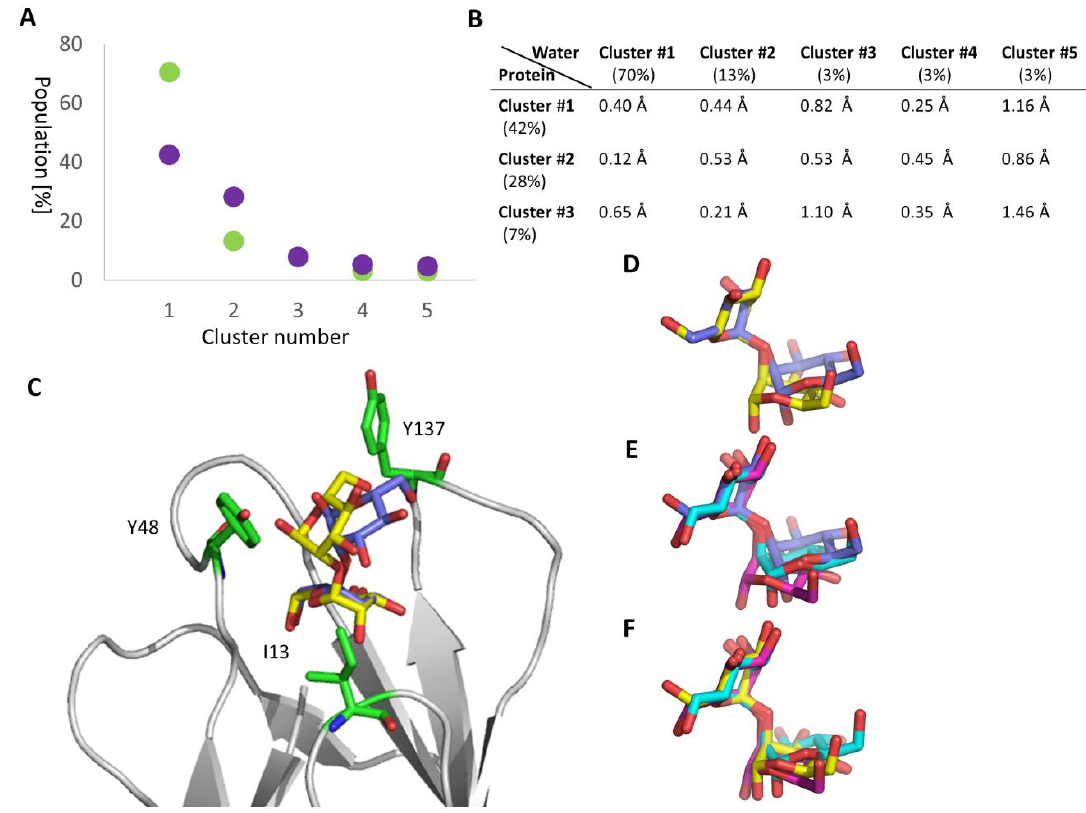
Figure 5. Molecular details of Man α 1,2Man binding to FimH. ( A ) Clusters featuring similar structures were extracted from the MD simulations of Man α 1,2Man in the FimH binding site (lilac) and in water (green) and plotted against their population occurrence (in %). Only the five highest ranking clusters are depicted, which account to 95% and 89% of the conformations in water and in the protein, respectively. ( B ) RMSD values between the representative conformation of each cluster in water and in the protein. ( C ) Overlay of the representative Man α 1,2Man · FimH complex structure from cluster #1 (lilac) and #2 (yellow). A few residues representative of the FimH binding site are depicted additionally (green). For all residues interacting with Man α 1,2Man see Figure 3. The protein is shown in white cartoon. To perform the overlay, the protein was superimposed. ( D ) Overlay of the cluster #1 (lilac) and #2 (yellow) of Man α 1,2Man in the Man α 1,2Man · FimH complex. To perform these and the following overlays, the non-reducing mannose was superimposed. ( E ) Overlay of cluster #1 (lilac) of the Man α 1,2Man · FimH complex with the cluster #1 (magenta) and #4 (cyan) of Man α 1,2Man alone in solution. ( F ) Overlay of cluster #2 (yellow) of the Man α 1,2Man · FimH complex with the cluster #1 (magenta) and #4 (green) of Man α 1,2Man alone in